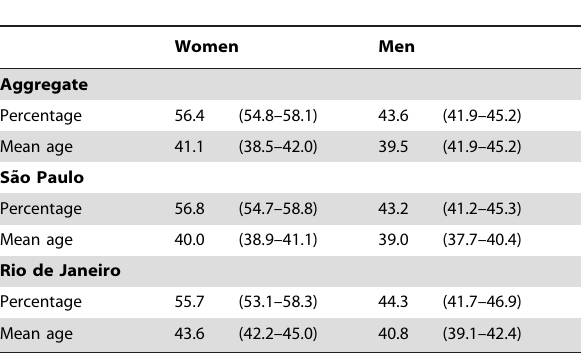
Table 2. Sex distribution and age mean by city and